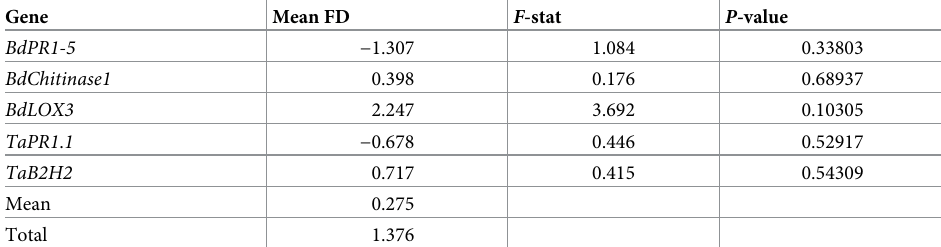
Table 4. Expression-level differences for chosen genes in leaves of Brachypodium distachyon (Bd) and wheat plants. Gene expression was detected as fold difference (FD) between plants inoculated only by pathogen and plants inoculated both by endophyte and pathogen to evaluate the effect potentially caused by endophyte on subsequent path- ogen infection.